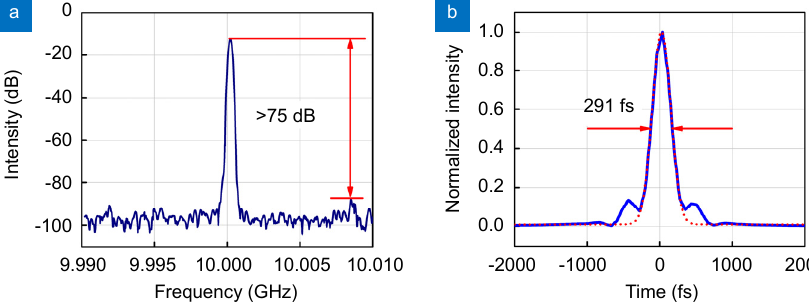
Fig. 3 | ( a ) RF spectrum from the broadened frequency comb at 20 dBm pump power (RBW=200 kHz and VBW=50 kHz). ( b ) Reconstructed temporal pulse profile with a FWHM duration of 291 fs after transmitting a 4 m SMF at 20 dBm pump power (blue solid curve) and Gaussian fitting curve (red dotted